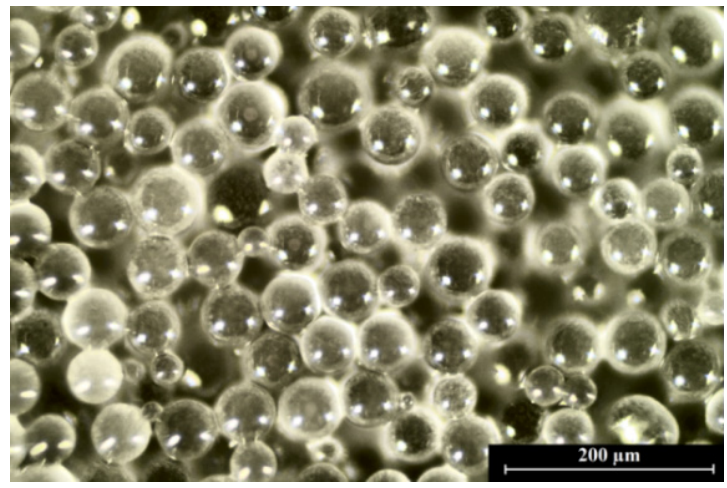
Figure 5. The image of PLA microparticles with Calendula officinalis flower extract observed by the optical microscope (scale bar = 200 μ m).